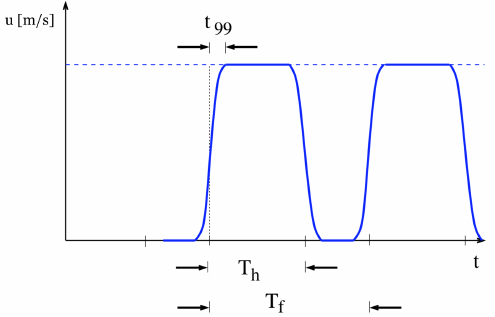
Figure 3. Illustration of the actuating boundary condition for periodic base